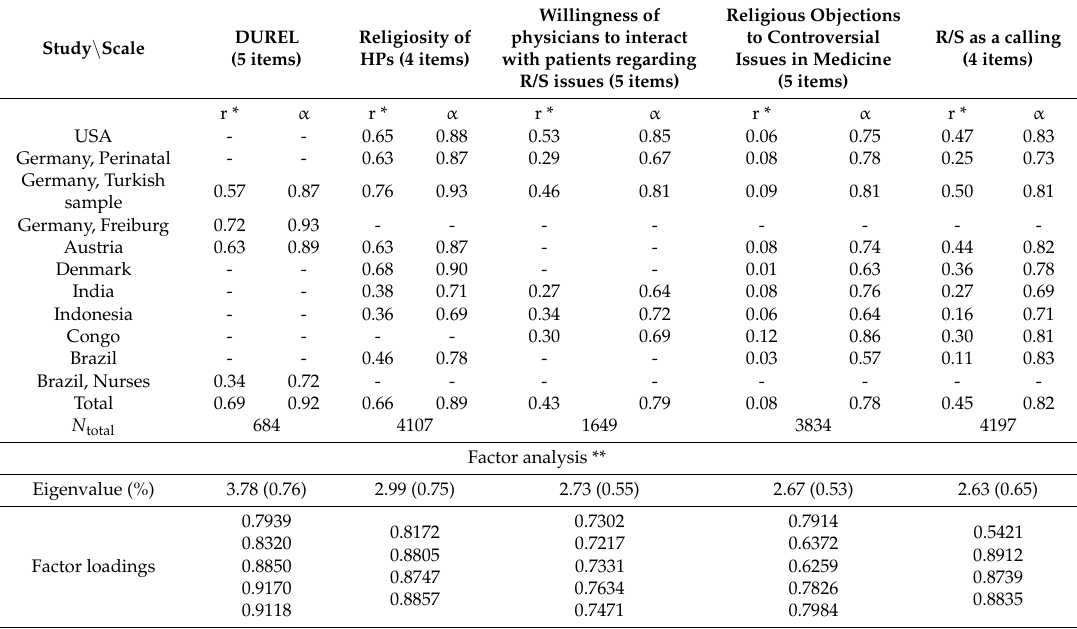
Table 6. Reliability